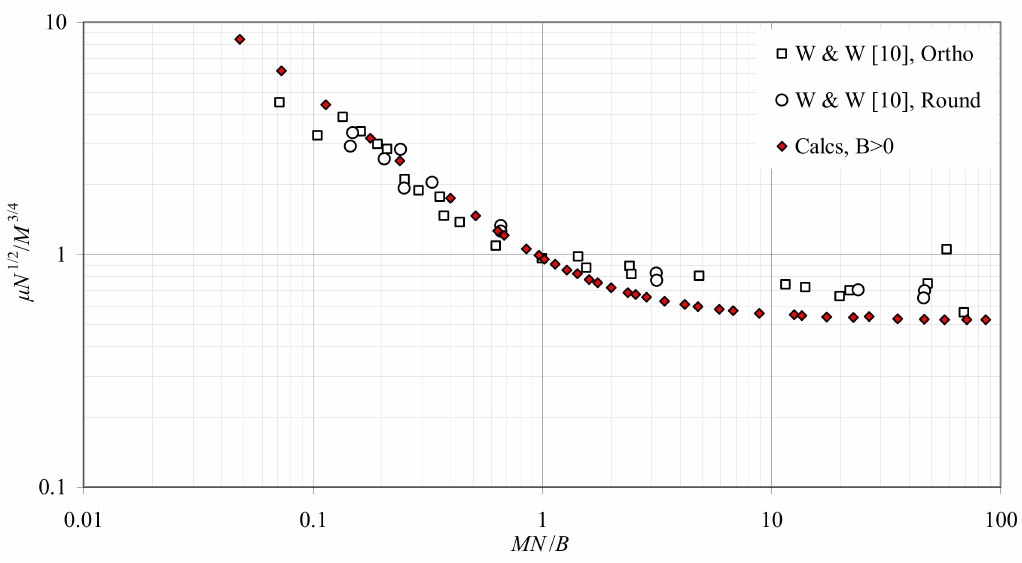
Figure 5. Normalized dilution plotted versus MN / B for positively buoyant jets from measurements of Wong and Wright [10] (squares and circles) and the computation using top-hat